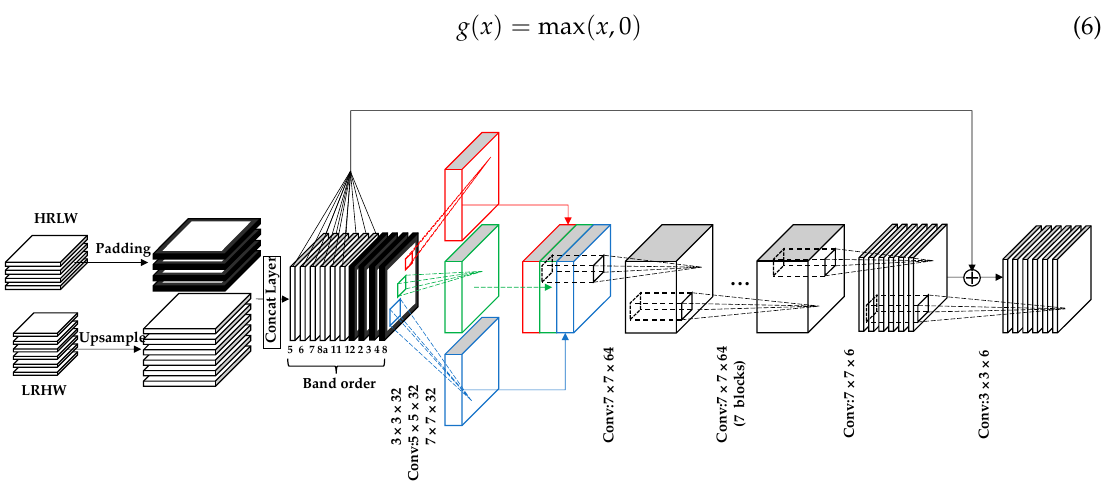
Figure 1. The architecture of the proposed width-space-spectrum residual network (WSSRN) model. After the convolutional layer and the activation function complete the feature extraction, the extracted features are further input into the reconstruction output layer, and the reconstruction output layer works as “fusion reconstruction” in the entire CNN, which is essentially a convolutional layer. Passing through the previous feature extraction work, the spectral features and the spatial features are distributed in di ff erent channels, so it is necessary that a convolutional layer is used to fuse the features. For a traditional CNN, the deeper the network, the more parameters it has and the more powerful nonlinear presentation capabilities it obtains. However, as the network gets deeper and deeper, it previous convolutional layers being unoptimized